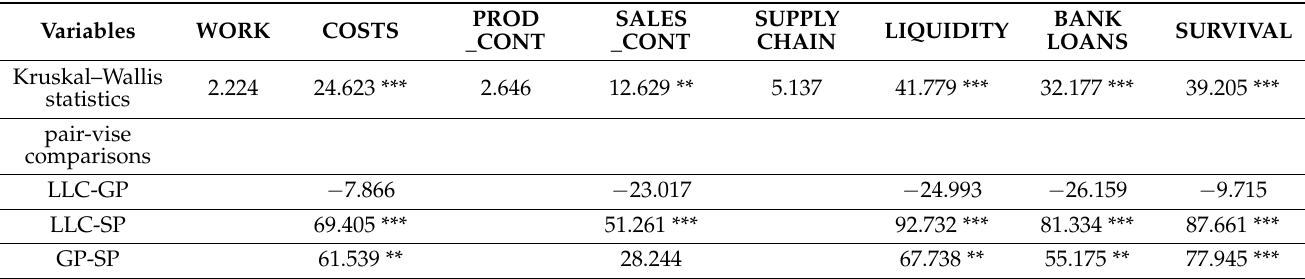
Table 4. Results of non-parametric ANOVA–the differences in COVID-19 risk perceptions between the business of different legal